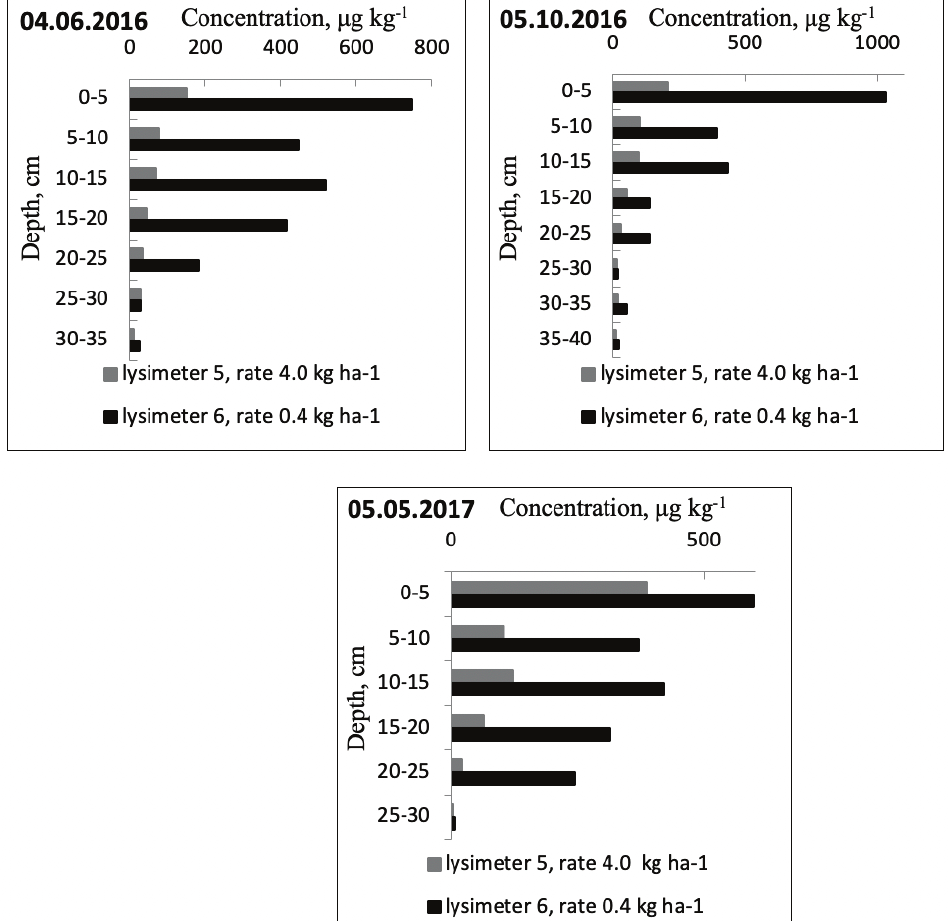
Figure 4: Migration of cyantraniliprole in the soil